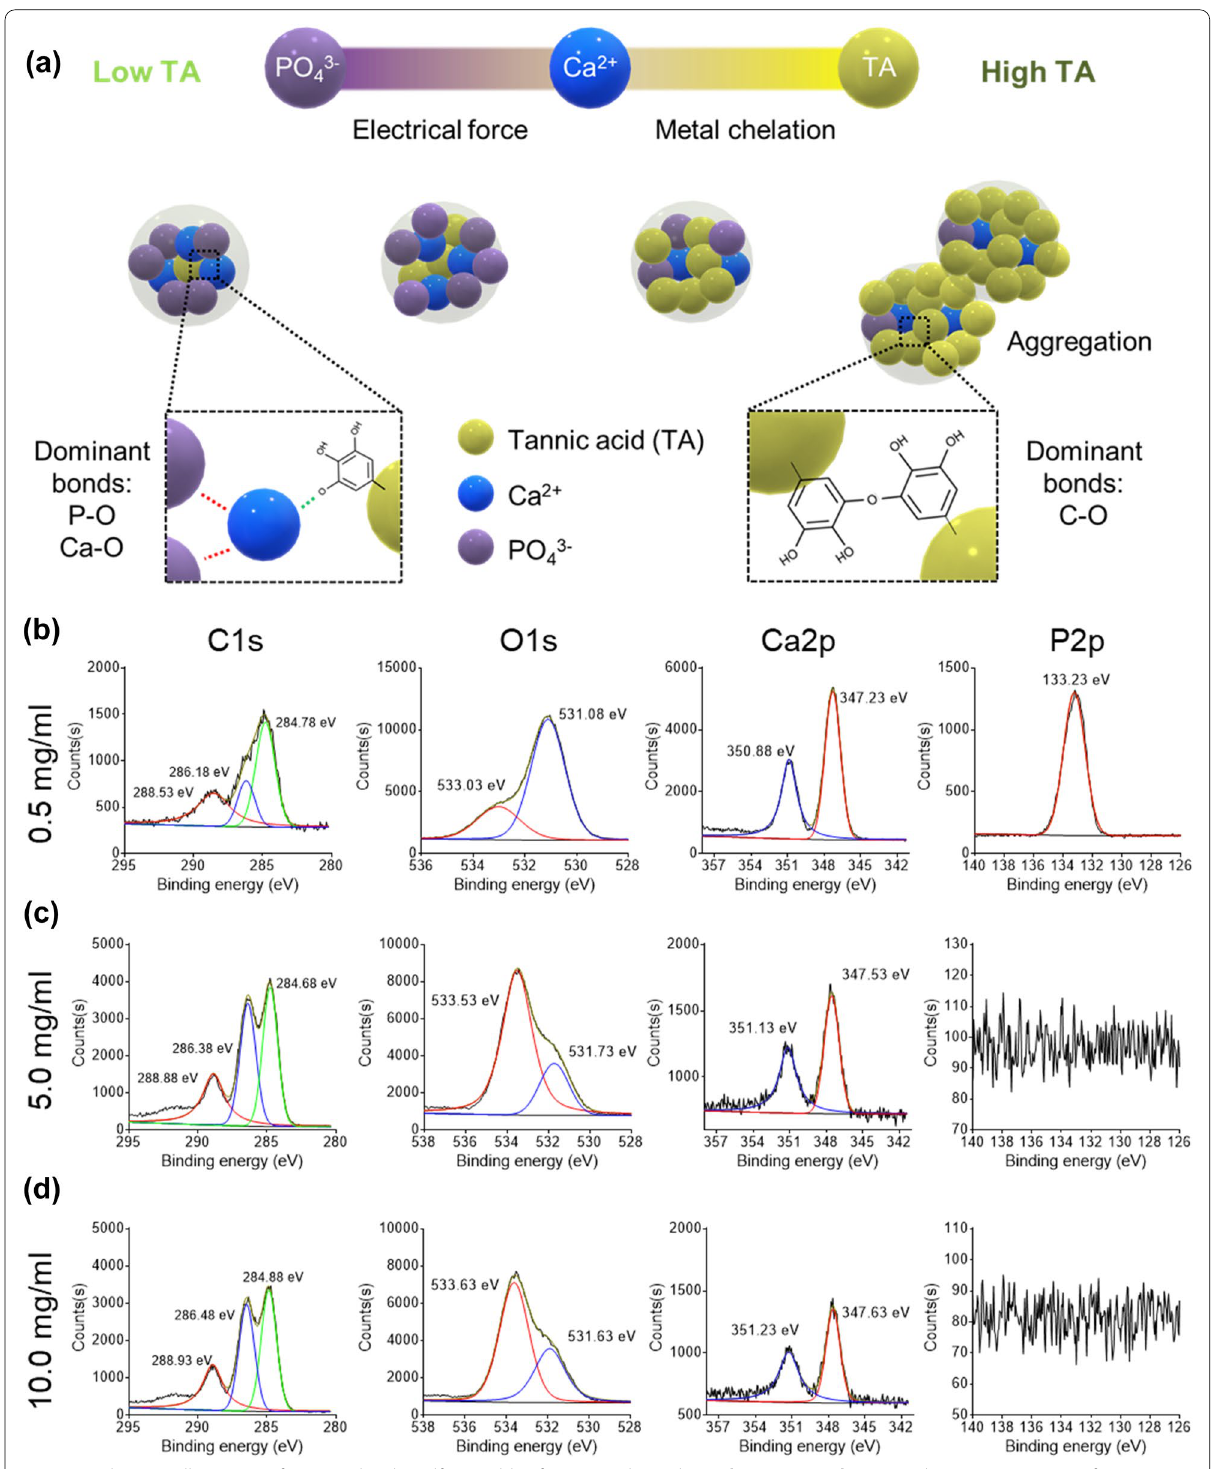
Fig. 2 a Schematic illustration of supramolecular self‑assembly of mTNs. High‑resolution b C1s, c O1s, d Ca2p, and e P2p XPS spectra of mTNs prepared using various concentrations of